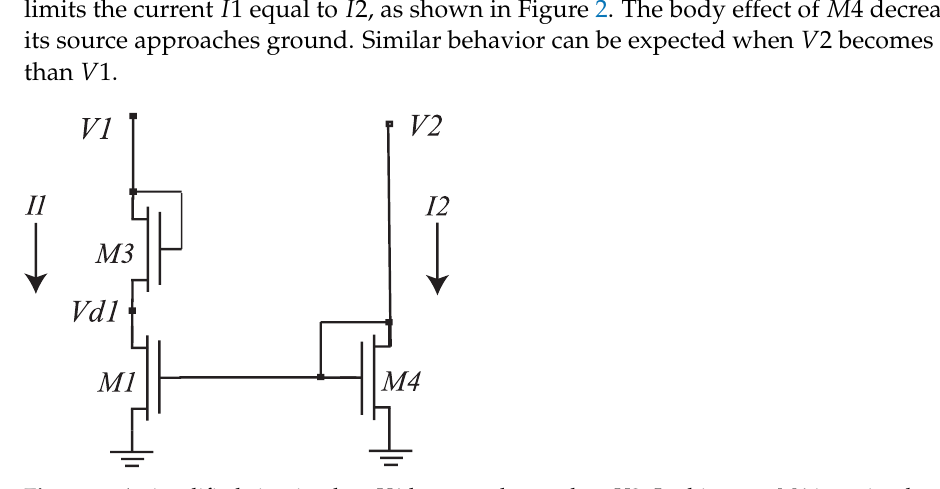
Figure 2. A simplified circuit when V 1 becomes larger than V 2. In this case, M 4 is omitted as it is in deep triode ( V 1 >> V 2 ) , and the circuit behaves as a simple current